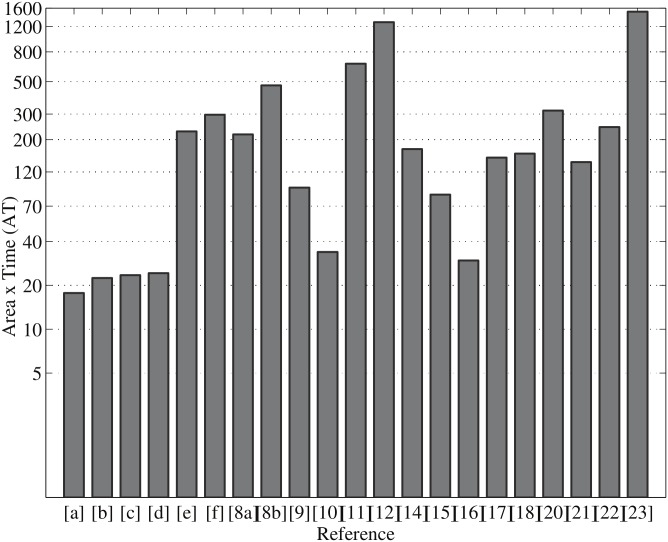
AT comparison of point multiplication ([a], [b], [c], [d], [e], and [f] represent our work) over GF(2163).